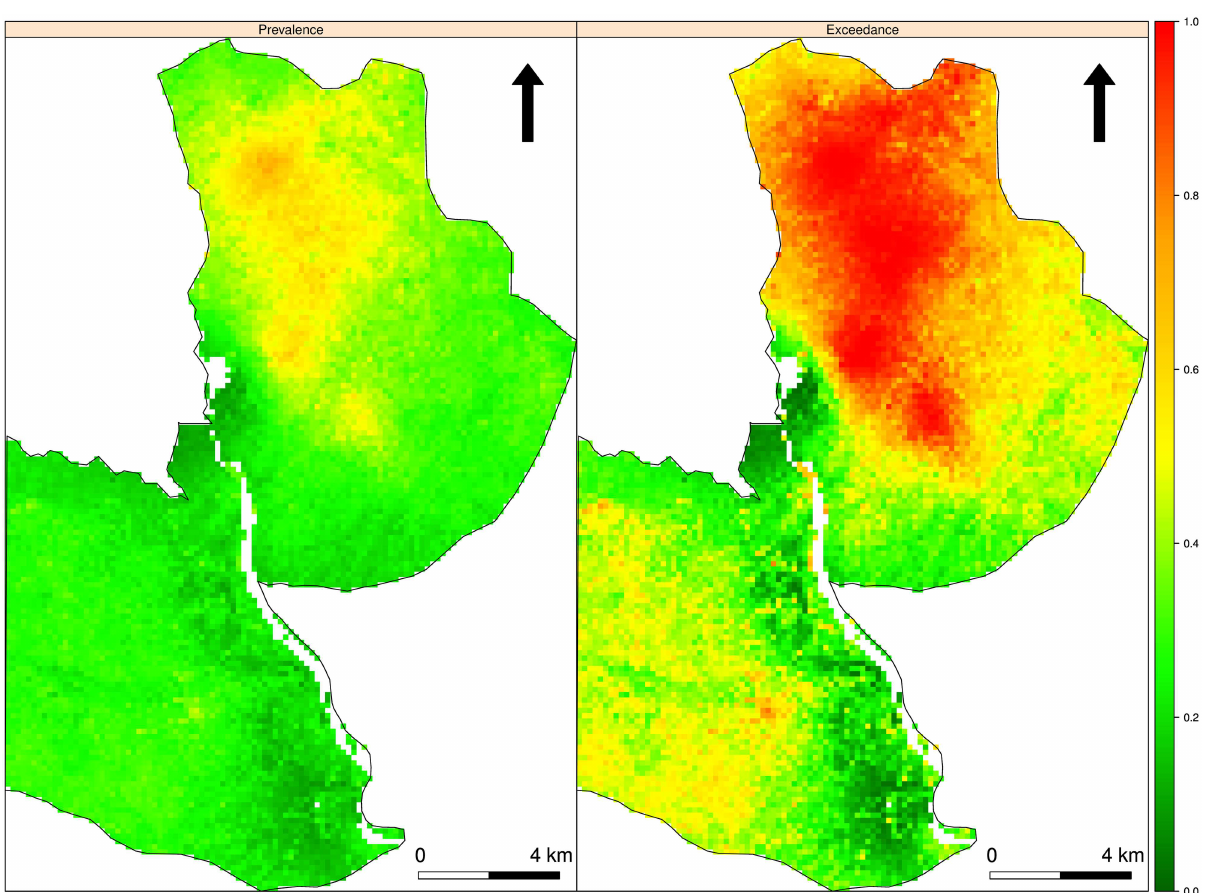
Fig 3. Malaria prevalenceand exceedance probabilities maps. Left panel shows malaria prevalence in children6–59 months in focal area B. The right-handpanel shows the map of exceedance probabilities P(x; 0 . 3) for the Bayesianprediction.